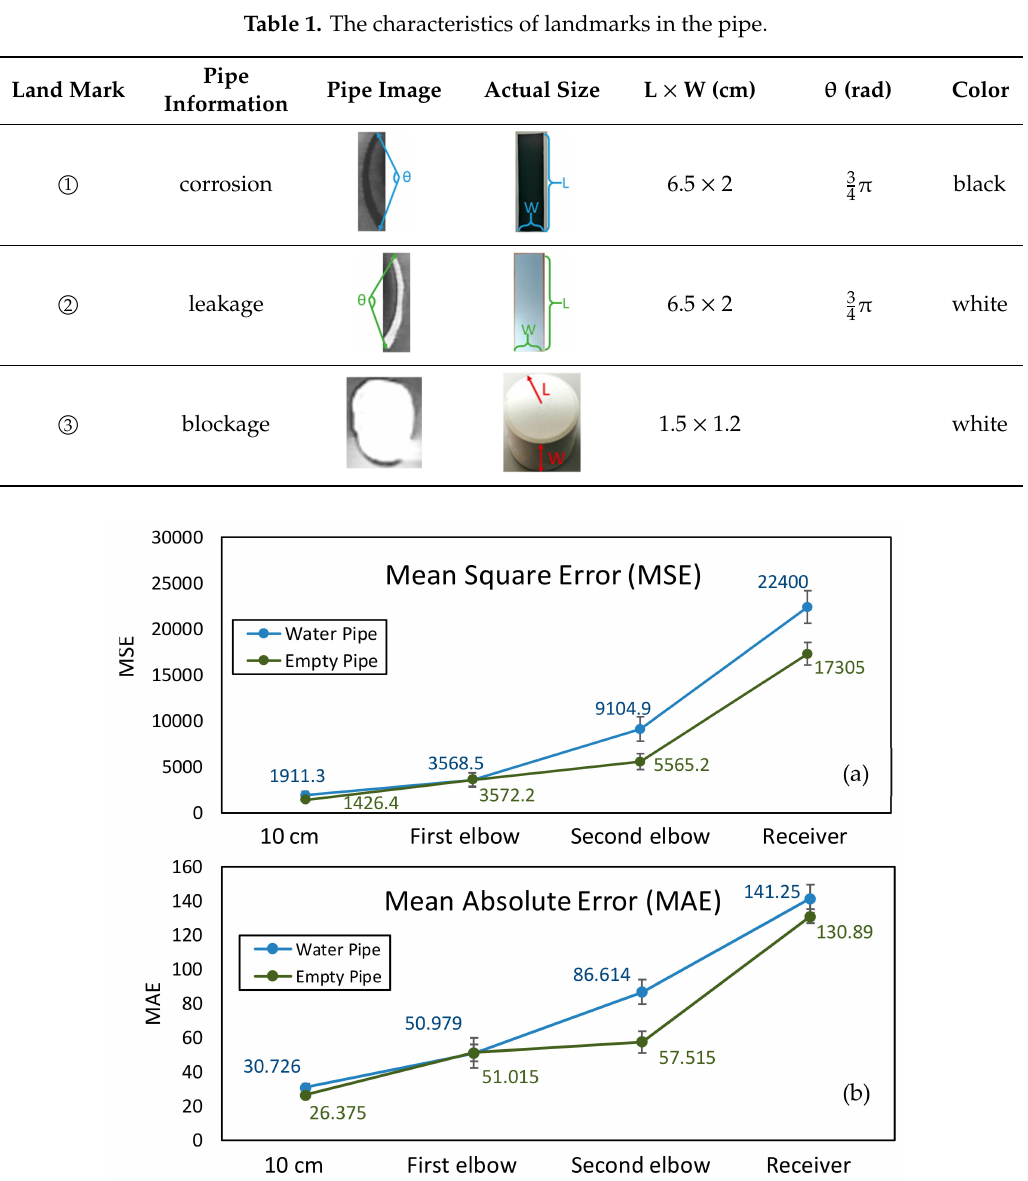
Figure 8. ( a ) MSE performance and ( b ) MAE performance for AISRT